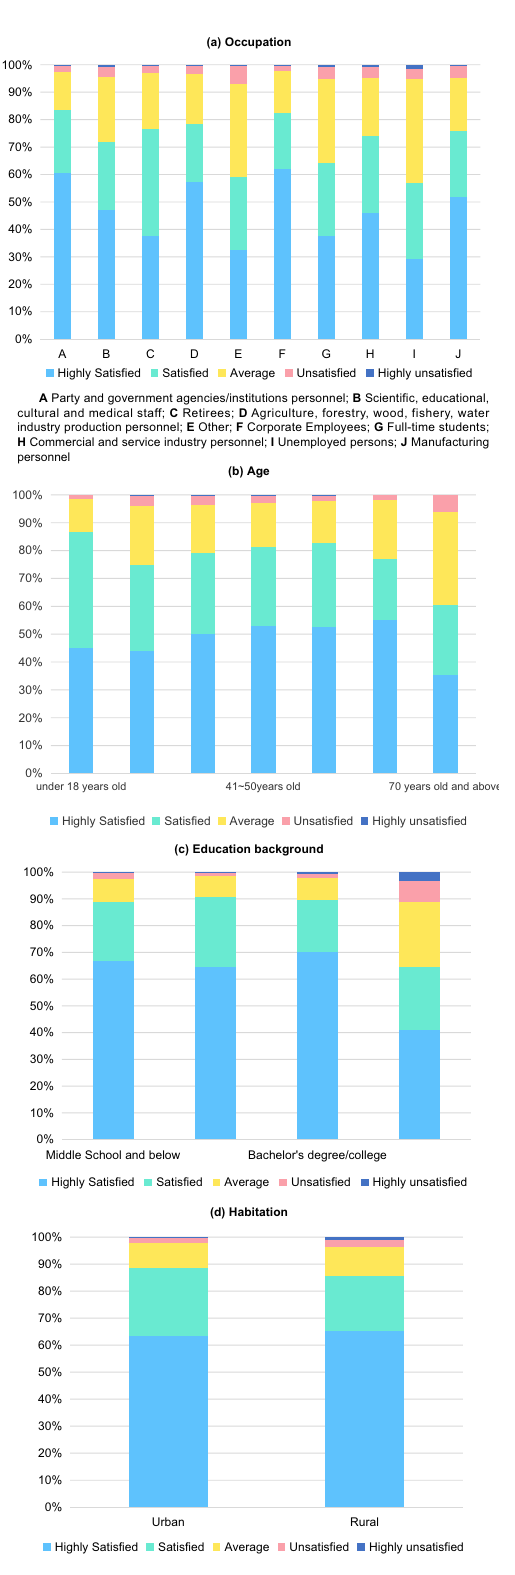
Fig. 6 Residents ’ attributes of satisfaction with human settlements.